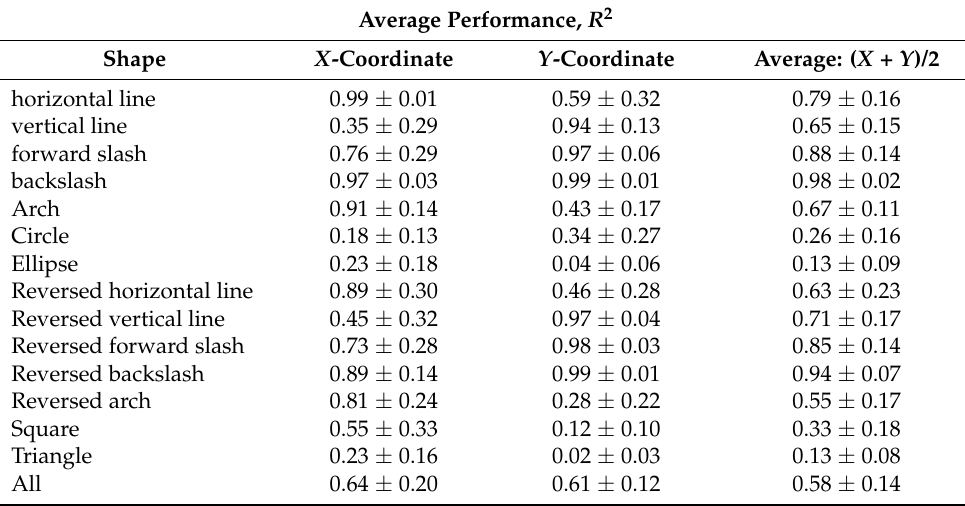
Table 10. Within-group reconstruction performance by the GEP: the average accuracy of each shape across the five subjects.